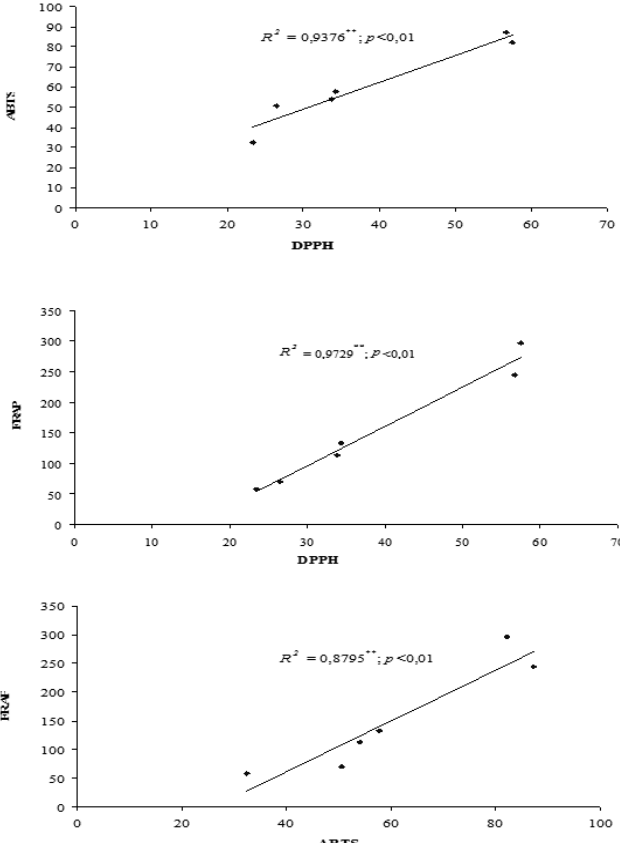
Fig. 6: Coefficients of determination between DPPH, ABTS and FRAP; ** significance at p